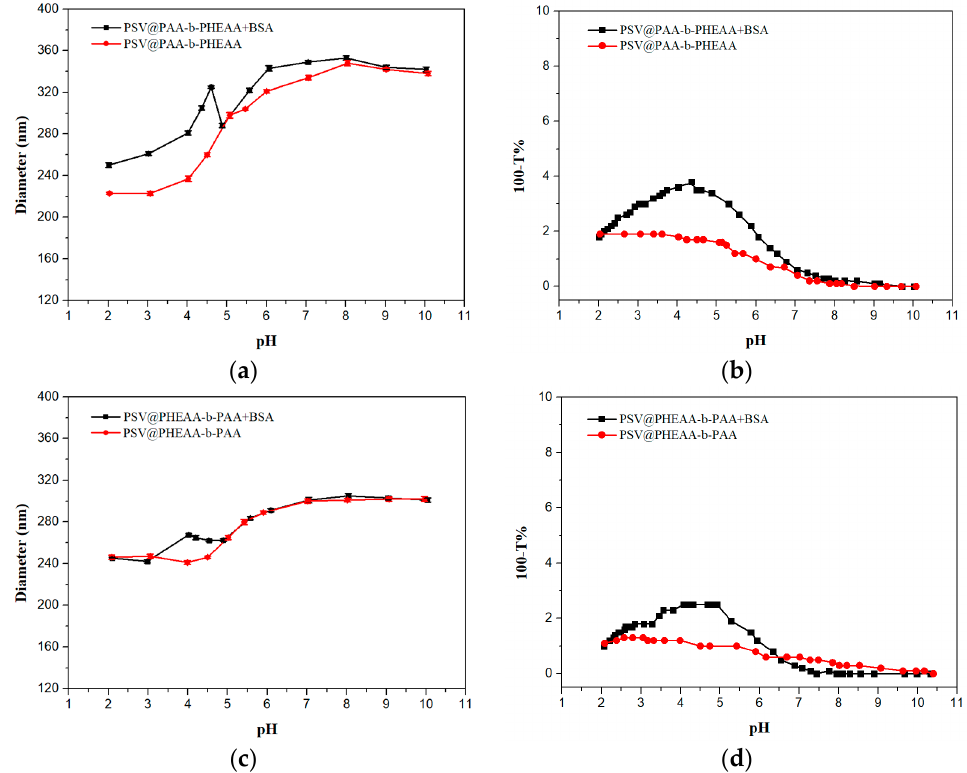
Figure 5. ( a ) Diameters and ( b ) turbidity of the mixture system of PSV@PAA-b-PHEAA with the BSA ( ) and BSA-free system ( ) and ( c ) diameters and ( d ) turbidity of the mixture system of PSV@PHEAA-b-PAA with the BSA ( ) and BSA-free system ( ) from pH 2 to pH 10.